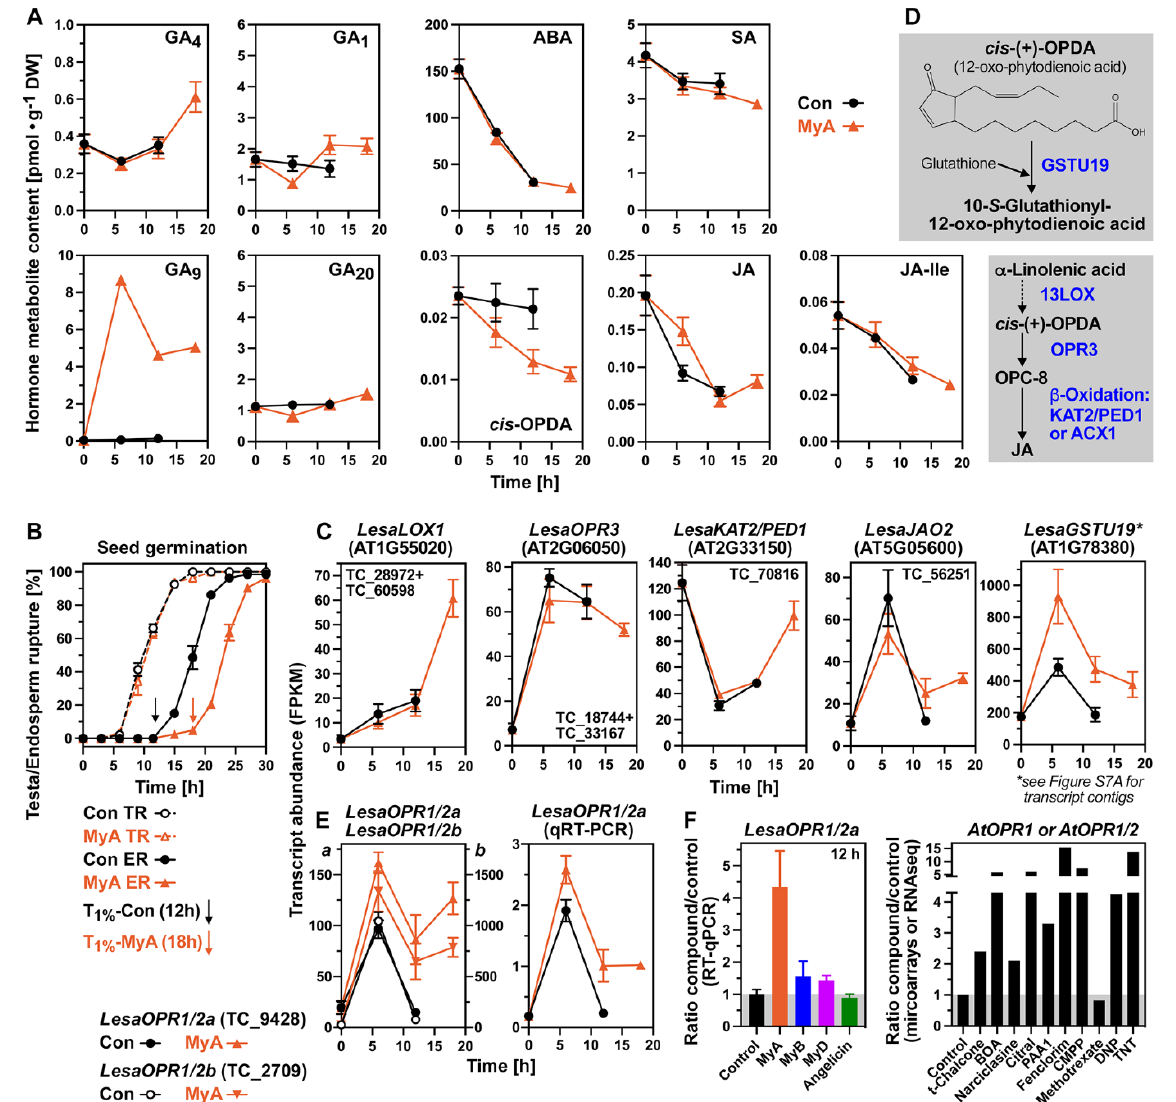
Figure 2. Hormone metabolites and associated gene expression in response to myrigalone A (MyA) treatment during Lepidium sativum seed germination. ( A ) Temporal patterns of endogenous hormone metabolites in whole seeds during germination at 20 ◦ C without (Con) or with 0.5 mM MyA added. Bioactive gibberellins (GA 4 and GA 1 ) and their direct precursors (GA 9 and GA 20 , respectively) are presented (see Figure S4 for other GA metabolites). Other hormones presented are cis-S (+)-abscisic acid (ABA), salicylic acid (SA), cis -(+)-12-oxophytodienoic acid (OPDA), jasmonic acid (JA) and it’s isoleucine conjugate (JA-Ile). Mean ± SEM values of five biological replicates. ( B ) MyA treatment does not affect the kinetics of testa rupture (TR) but delays the onset of endosperm rupture (ER) of the seed populations, as indicated by the arrows indicating the time when 1% ER was observed (T 1% ). ( C ) Expression patterns of L. sativum ( Lesa ) genes involved in OPDA and JA metabolism as affected by the MyA treatment of germinating seeds. The names of L. sativum ( Lesa ) genes and the corresponding A. thaliana orthologs (AGI in brackets) are provided; see abbreviations for full names of genes. ( D ) Simplified scheme of jasmonate biosynthesis and OPDA conjugation to glutathione by GSTU19. ( E ) LesaOPR1/2a and LesaOPR1/2b transcript expression patterns. ( F ) Effects of treatments with various compounds on OPR1/2 transcript expression; see main text for details. Transcript abundances for L. sativum are presented as mean ± SEM values based on 4–5 (FPKM) and 3 (qRT-PCR) biological replicates; relevant transcript contigs (TC-IDs) are included for each